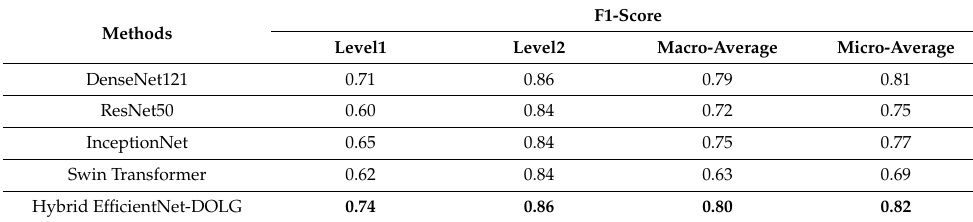
Table 9. Comparing results between the five deep learning models on the COVID-19 severity assessment task with respect to F1-score